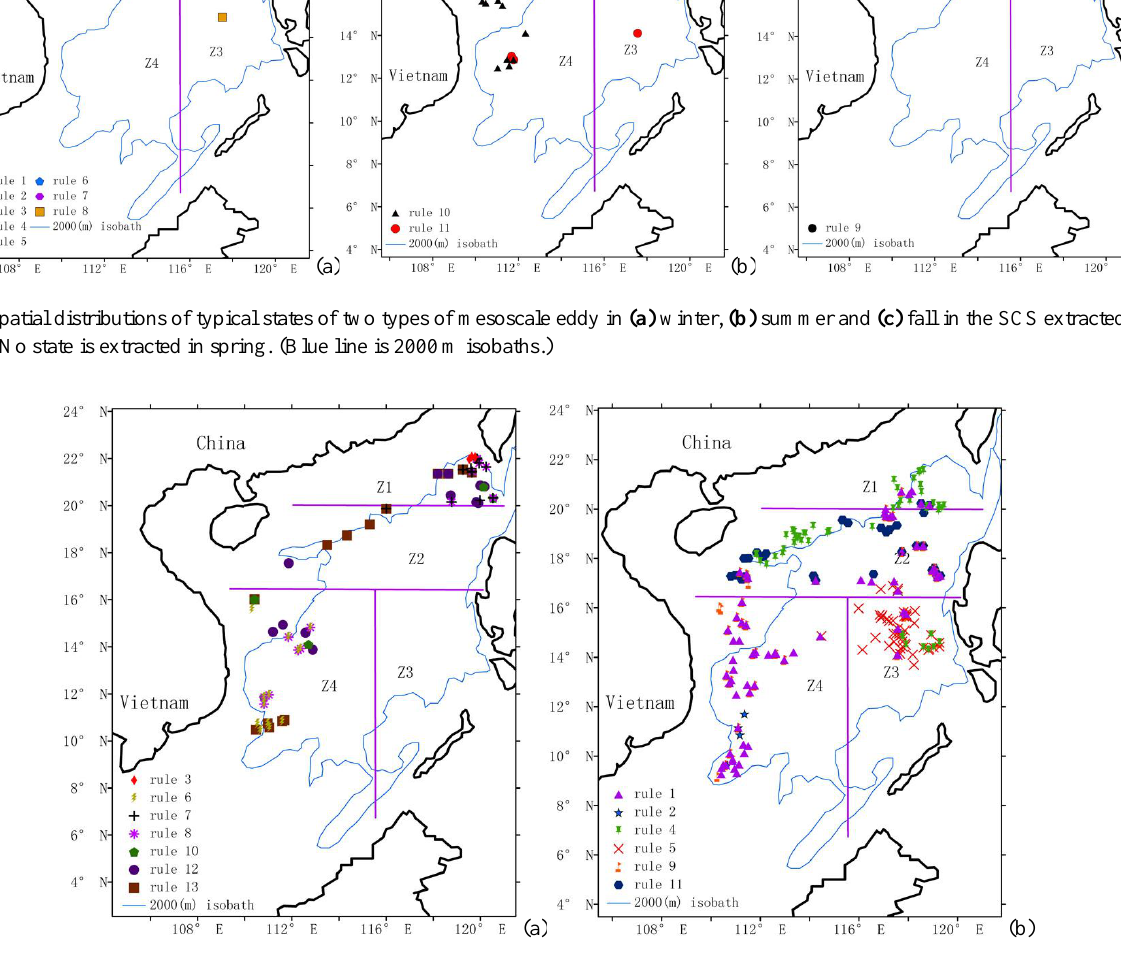
Fig. 8. Spatial distribution of all typical (a) cold-eddy states and (b) warm-eddy states in the SCS extracted from Table 7. (Blue line is 2000m